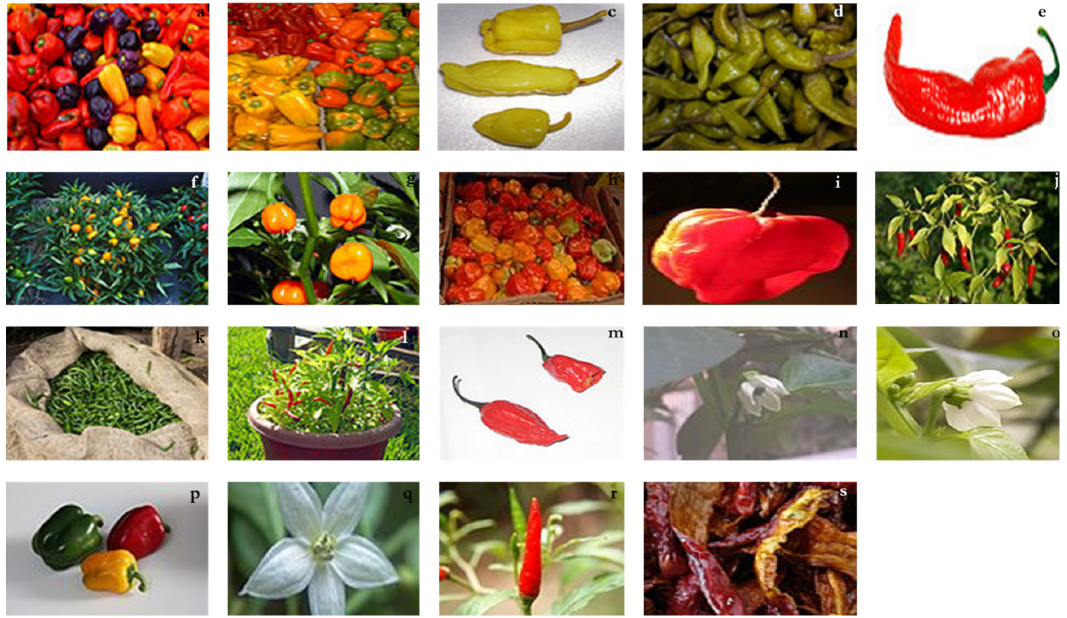
Figure 1. C. annuum cultivars